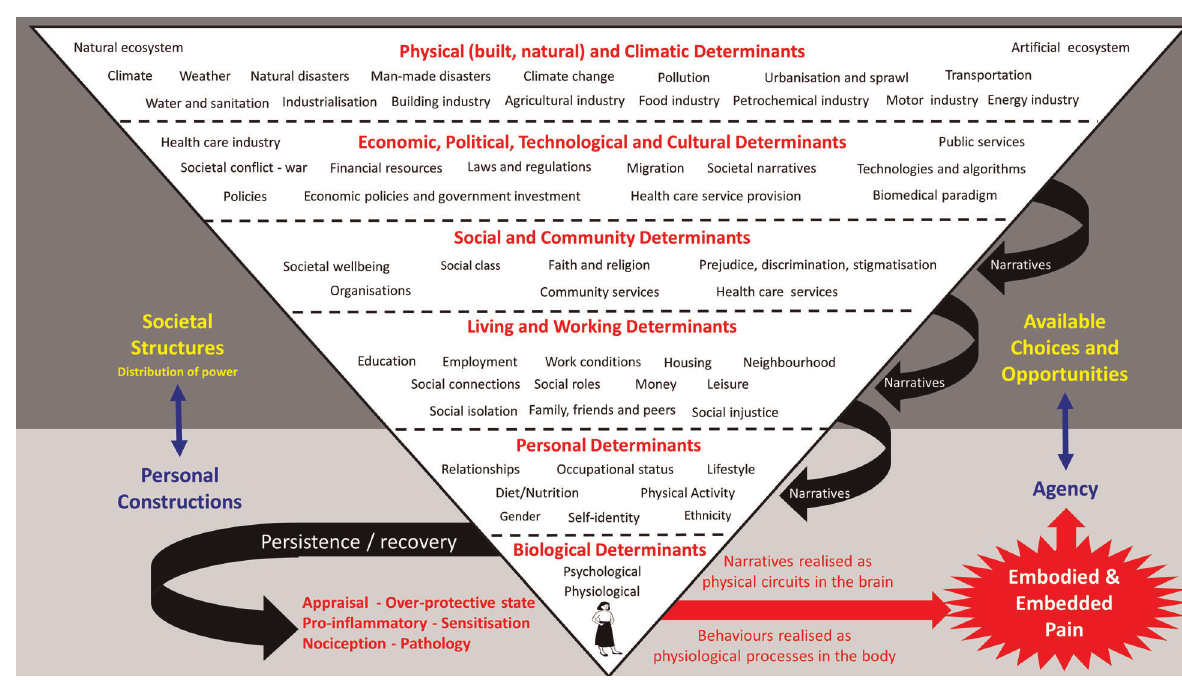
FIGURE 1 A “ fi rst step ” to identify generic socio-ecological factors with potential to in fl uence the lived experience of persistent pain and limit choices and opportunities for recovery. The schematic was developed by adapting the model of ecological development by Bronfenbrenner (55). Items (determinants) were organised within and between levels ad hoc; hence, the purpose of the schematic is to encourage a systematic and comprehensive analysis in the future. Attention is drawn to the role of information (words and symbols) that arise in meta-levels to form frames, metaphors, memes, and narratives, that lubricate the painogenic milieu and shape a person ’ s bodily self, including identity, by altering circuitry and processing in the brain